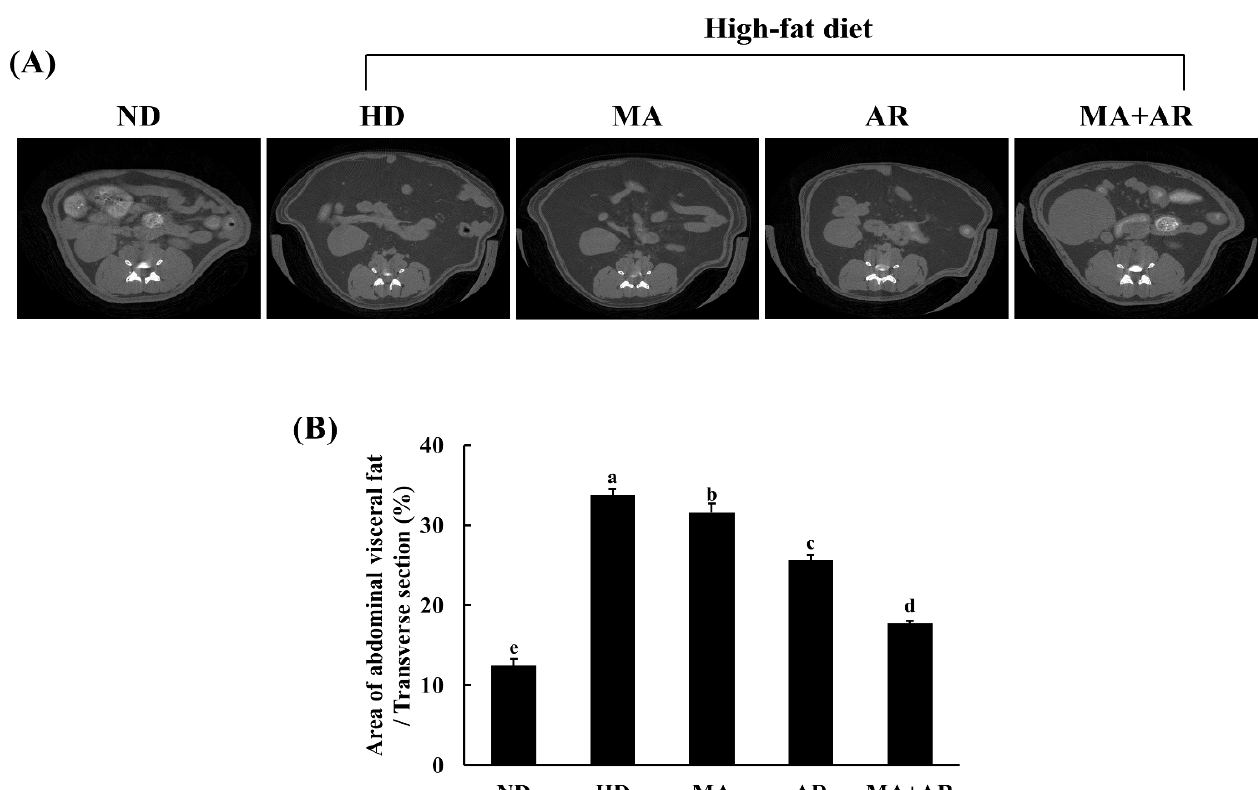
Figure 3. Micro-CT analysis of abdominal fat volume in the experimental mice. M. alba extract (400 mg/kg bw), A. melanocarpa extract (400 mg/kg bw), or mixture of these two extracts was orally administered to experimental mice fed a high-fat diet for 14 weeks. ( A ) Micro-CT image of abdominal mouse area, ( B ) percentage of visceral fat volume. ND, normal diet, HD, high-fat diet, MA, high-fat diet + M. alba 400 mg/kg bw, AR, high-fat diet + A. melanocarpa 400 mg/kg bw, MA+AR, high-fat diet + mixture of M. alba and A. melanocarpa (400 mg/kg bw). Results are expressed as means ± S.D ( n = 10). Means with different superscript letters (a, b, c, d, e) are significantly different from each other by Duncan’s test of ANOVA at p < 0.05. “a” denotes the highest value and “e” represents the lowest value.